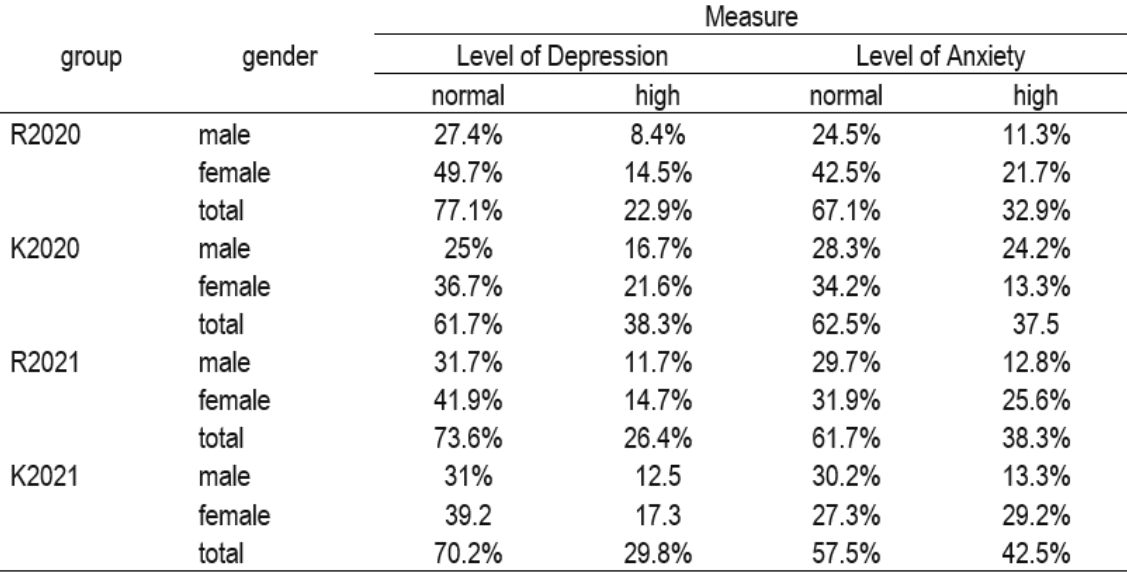
The percentage of girls and boys in groups with normal and high levels of anxiety and depression in 4